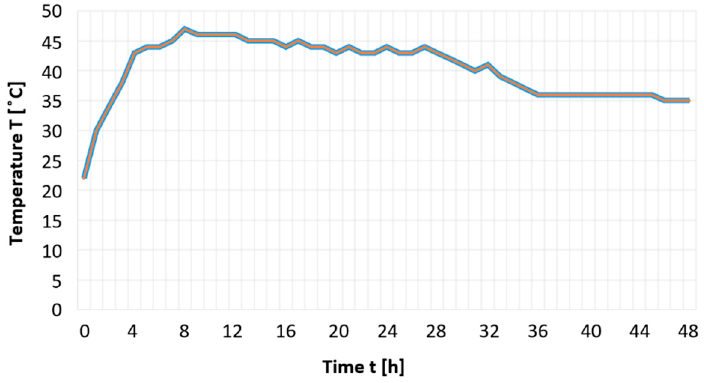
Figure 8. Graphical display of the courses of the temperature on the surface of the BR TS 050 support body during the trial run. Table 4. Values of natural BR TS 050 frequencies measured after the trial run (configuration A).